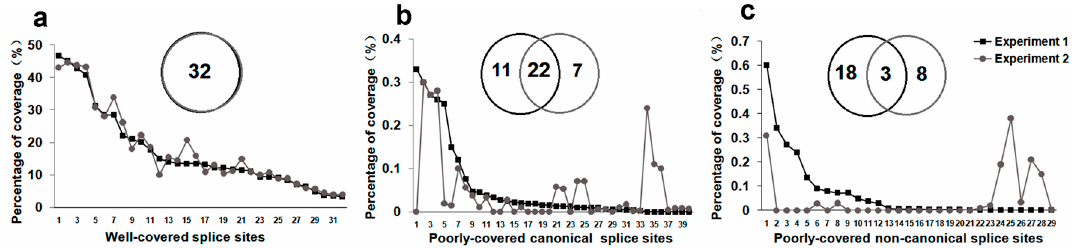
Figure 2. Reproducibility of splice sites (SSs) detected in two 3 ′ -RACE experiments. ( a ) Reproducibility of 32 annotated SSs; ( b ) reproducibility of 40 poorly covered canonical SSs; ( c ) reproducibility of 29 poorly-covered non-canonical SSs. Y axis of line chart is the percentage of coverage (reads spanned intron/reads covered target gene × 100 (%)). SSs were arranged from largest to smallest according to the percentage of coverage in Experiment 1. Left circle, SSs detected in Experiment 1; right circle, SSs detected in Experiment 2; the intersection of the left and right circles denotes SSs detected in both experiments.